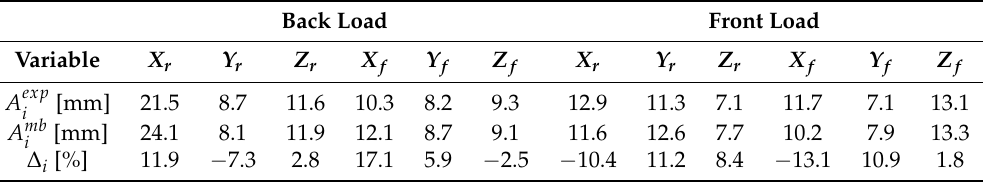
Figure 8. Multibody and experimental displacement envelopes: ( a ) X r counter load. ( b ) Z f counter load. ( c ) Y r middle load. Table 3. Back and front loads: Amplitude and percent difference of multibody/experimental results.